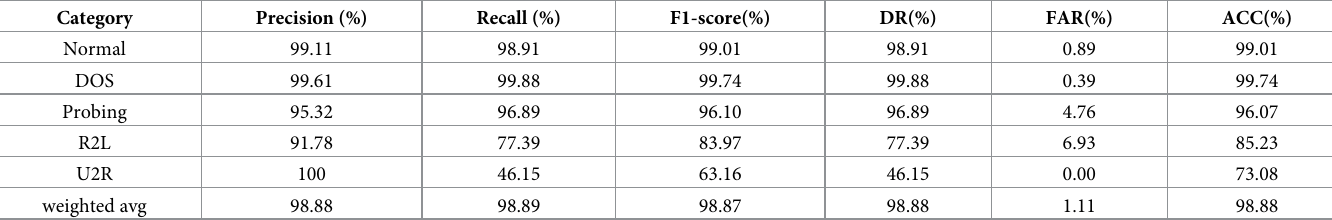
Table 5. Experimental results for different performance metrics in five categories of the KDDTrain+ dataset.